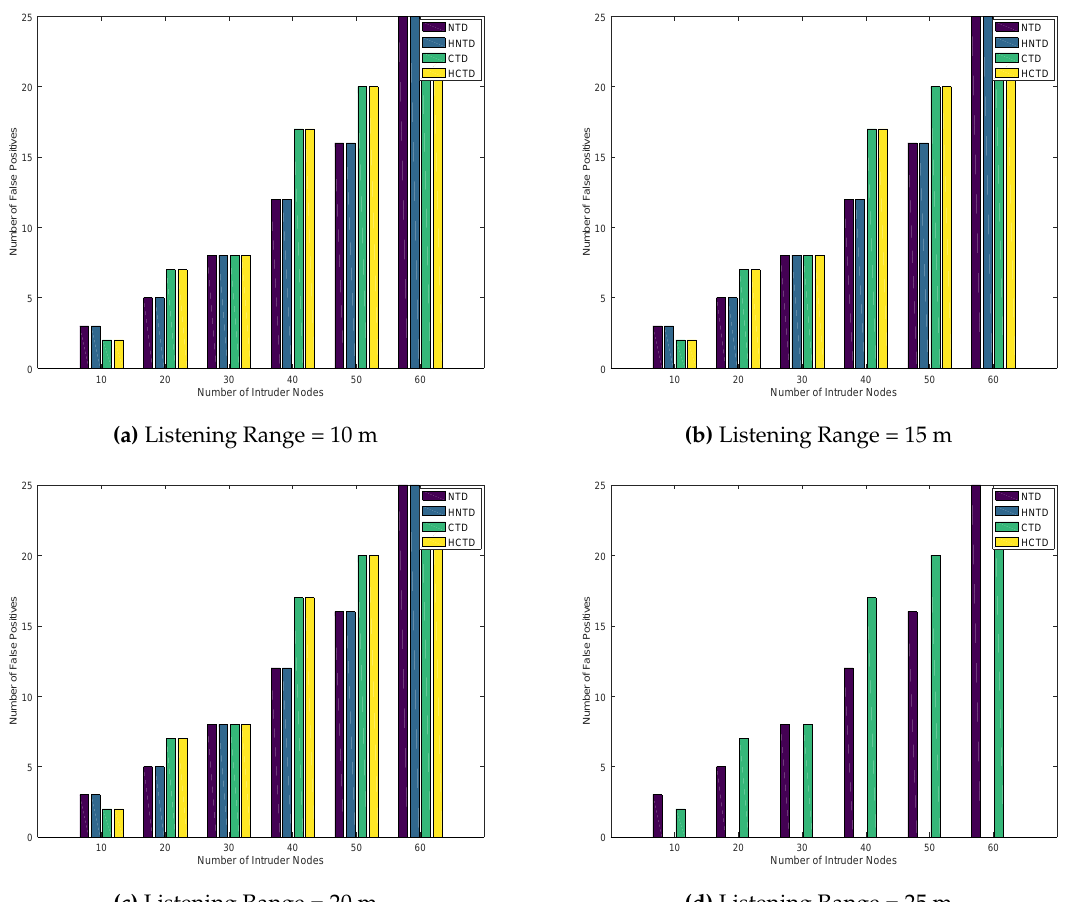
Figure 10. Number of False Positives for Randomly placed